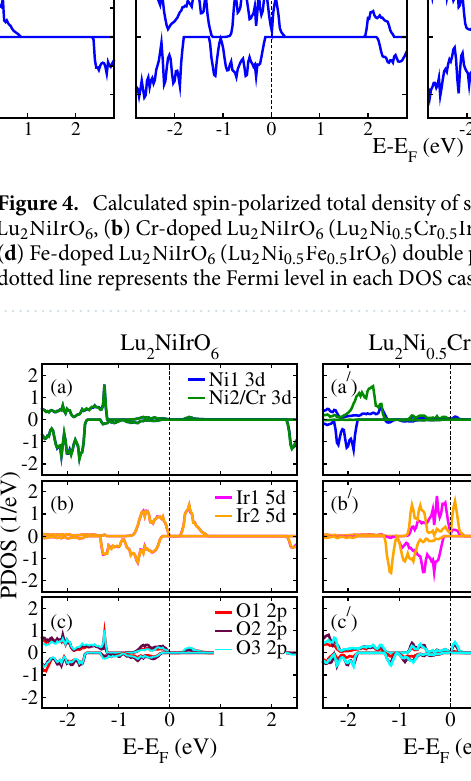
Figure 5. Calculated spin-polarized partial density of states (PDOS) within a GGA + U method for ( a / a ′ ) Ni1 and Ni2/Cr 3 d , ( b / b ′ ) Ir1/Ir2 5 d , and ( c / c ′ ) O1/O2/O3 2 p orbitals in undoped Lu 2 NiIrO 6 (left column)